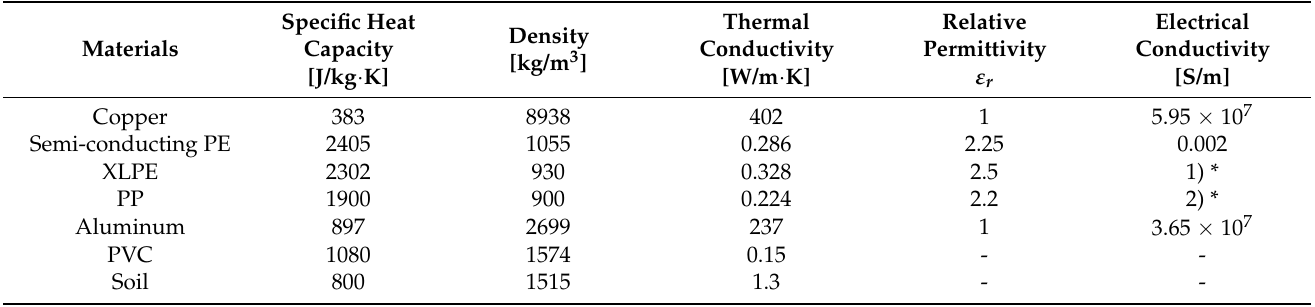
Table 3. Material properties of the cables applied in FEM simulation (@ Room temperature).